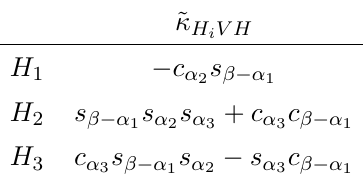
Table 4 . The e(cid:11)ective Yukawa couplings (cid:20) H eq. (2.30), in type I and type II.